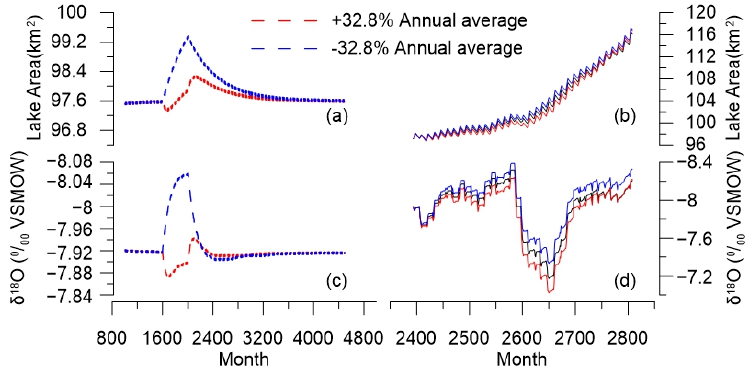
Figure 5. Sensitivity analysis results for temperature. ( a ) Lake area change response to temperature variation at steady status; ( b ) lake area change response to temperature variation at transient status; ( c ) δ 18 O of lake water change response to temperature variation at steady status; and ( d ) δ 18 O of lake water change response to temperature variation at transient status.